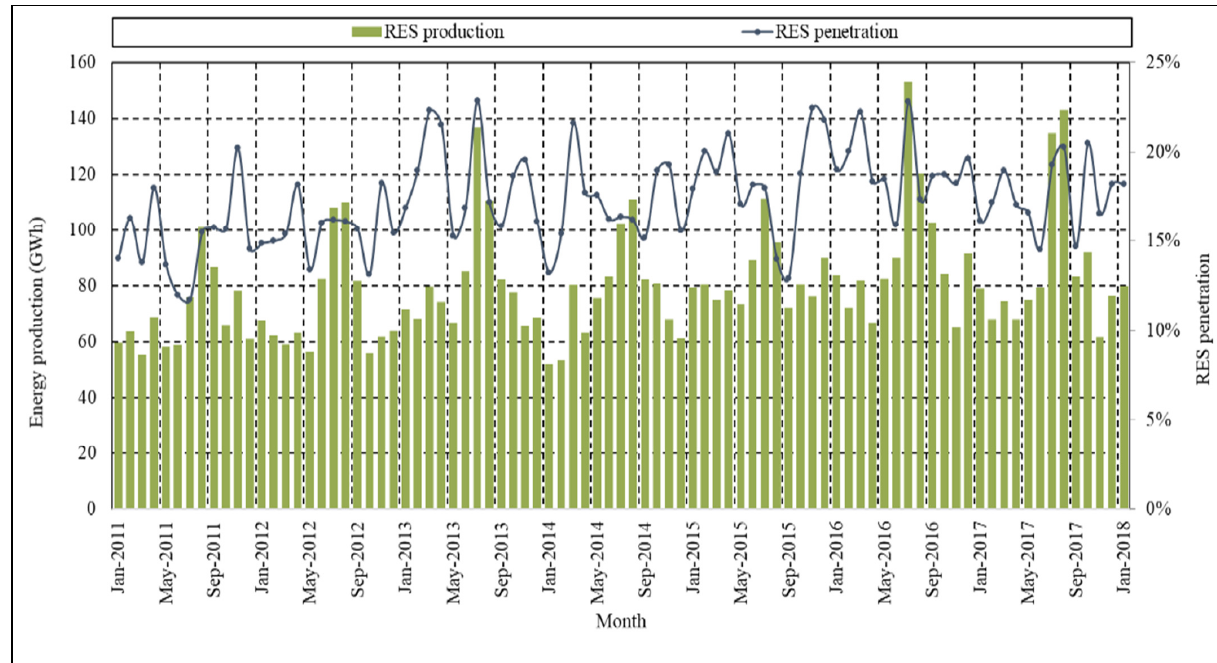
Figure 1. The Renewable Energy Sources (RES) contribution on the Non-Interconnected Islands’ (NIIs) electricity con- sumption.